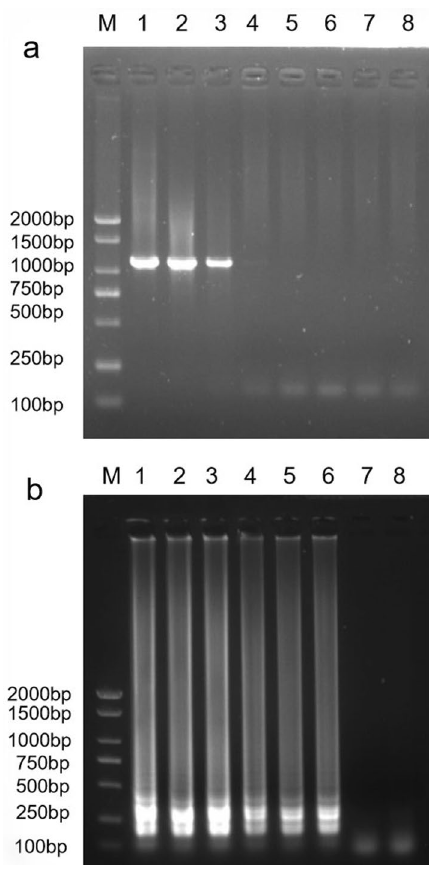
Figure 6. Sensitivity comparison of the PCR and LAMP methods for the detection of SVBV. ( a ) Detection of PCR products by agarose gel electrophoresis; ( b ) detection of LAMP products by agarose gel electrophoresis; Lane M, DL2000 DNA Marker; lane 1, DNA of SVBV; lanes 2–7, 10-folds serial dilutions of DNA of SVBV by 10 –1 , 10 –2 , 10 –3 , 10 –4 , 10 –5 , 10 –6 ; lane 8, negative control. The full-length gels are presented in Supplementary Fig.